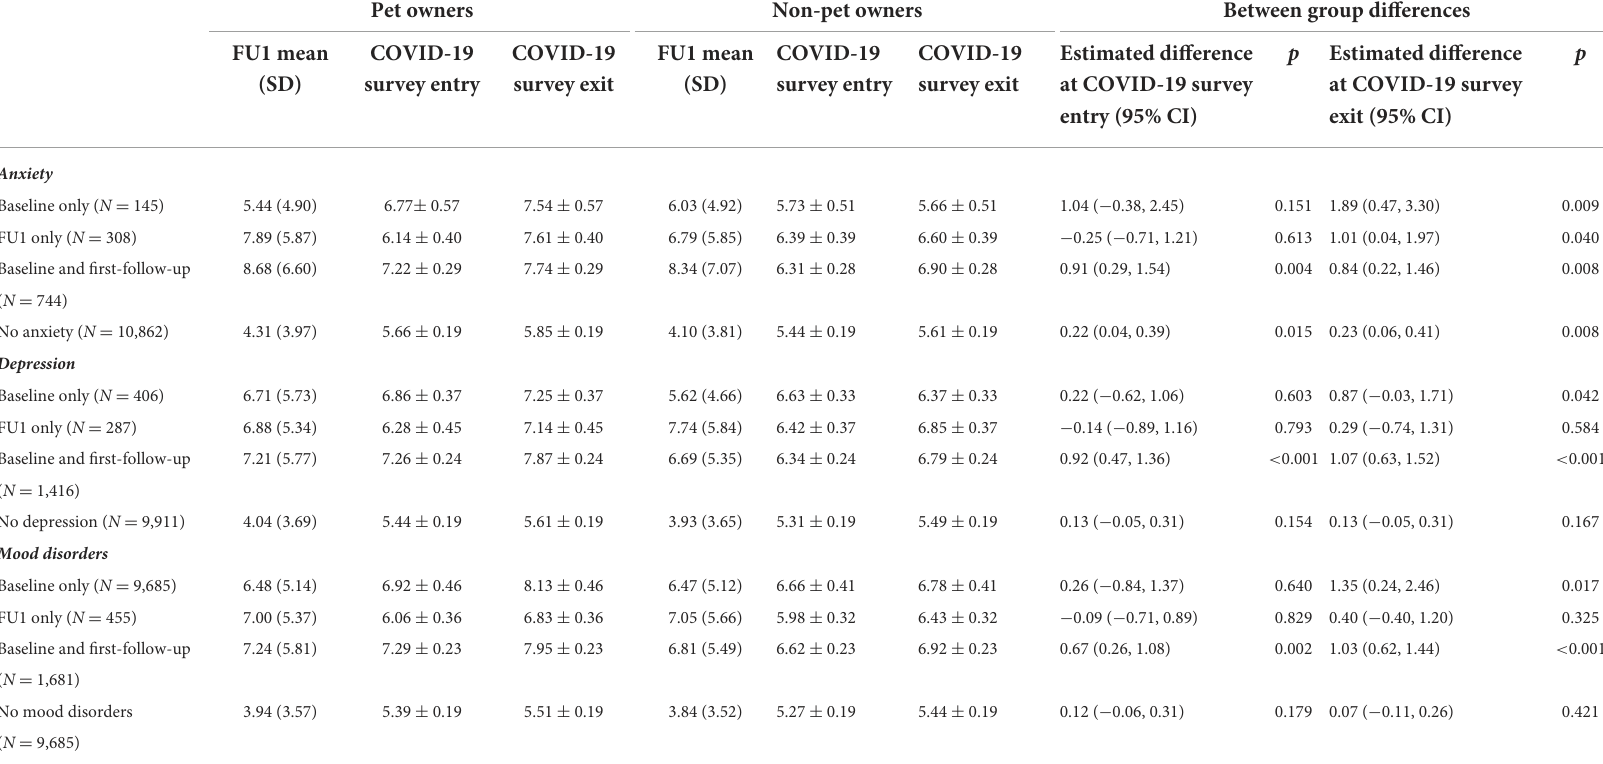
TABLE 6 Estimated marginal means and standard errors for changes in 10-item Center for Epidemiological Studies Depression Scale (CESD-10) score at FU1 (i.e., 2015–2018), and COVID-19 Survey entry and exit based on changes in mental health disorder status from baseline (i.e., 2010–2015) to FU1 and pet ownership at